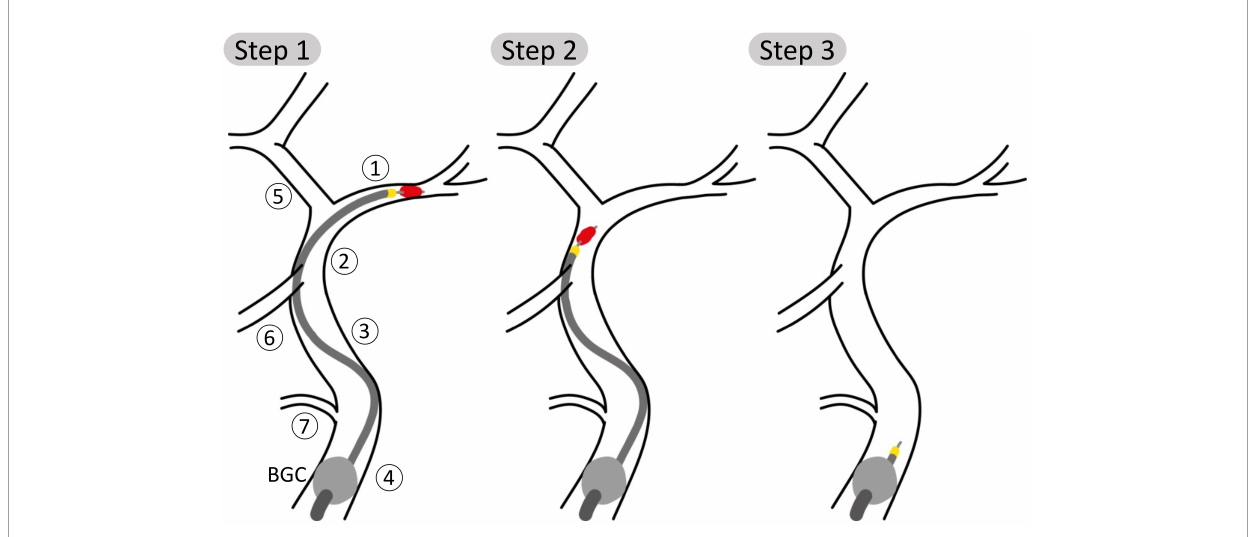
FIGURE2 Schematic representation of steps 1, 2, and 3 of the aspiration thrombectomy procedure with the balloon guided catheter (BGC, gray ball) placed in the Internal Carotid, proximal 1 (ICApp) and aspiration applied on the proximal face of the thrombus. Vessel numbering is the same as in Figure 1 . (Step 1) The aspiration catheter and stent retriever engage the clot; (Step 2) the clot is retrieved while aspiration is still applied; (Step 3) following successful removal of the clot, aspiration is still applied to avoid distal embolization.